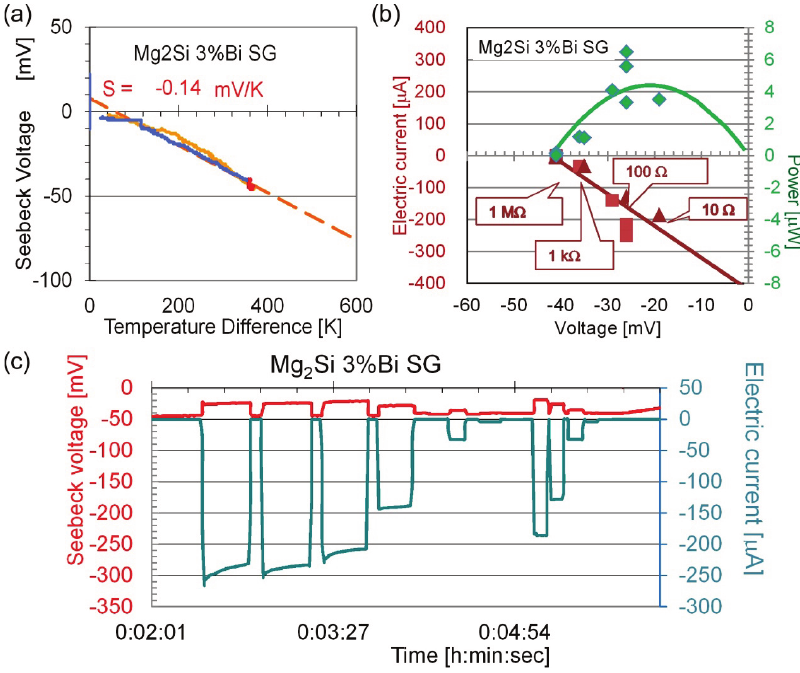
Figure 5. Measurement of ( a ) Seebeck coefficient; ( b ) electric current and out-put power at Δ T = 363 K under load resistors as marked; ( c ) time dependence of voltage and electric current at Δ T = 363 K of the Mg Si + 3%Bi specimen, which was SPS sintered at 400 °C 2 from synthesized powder pressed under glove